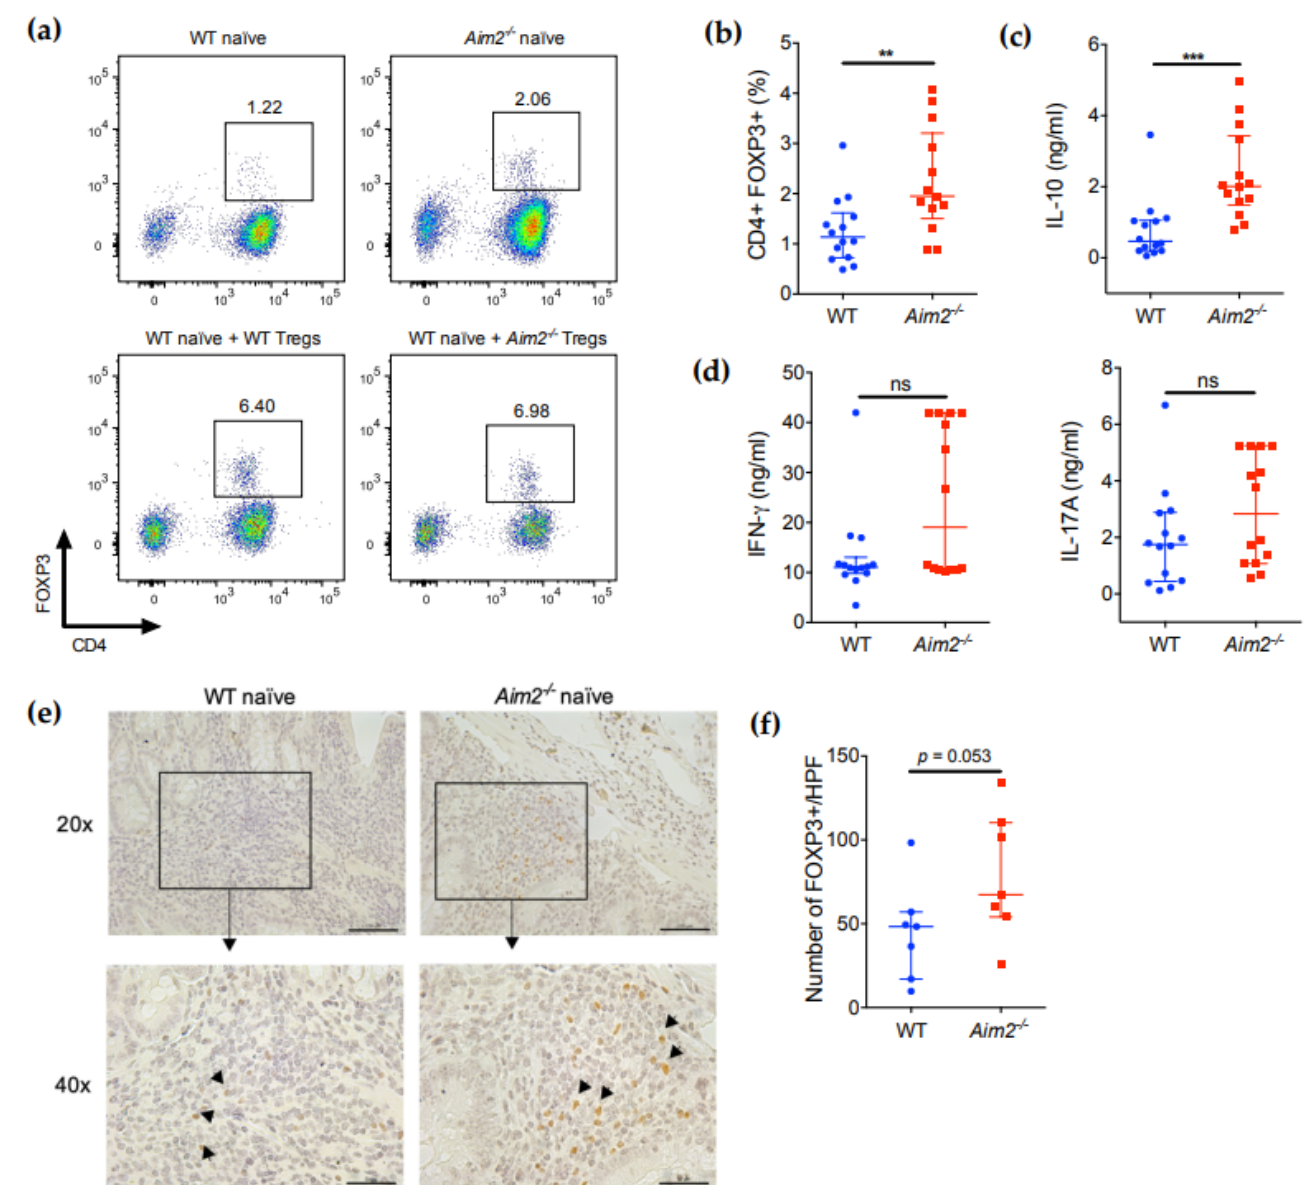
Figure 5. Aim2 − / − naïve T cells show increased differentiation into FOXP3 + cells in vivo. ( a ) Flow cytometry analysis of FOXP3 expression in splenic CD4 + cells isolated from Rag1 − / − mice 15 weeks after transfer of naïve T cells (CD4 + CD45RB high CD25 − ) from WT ( n = 14) or Aim2 − / − ( n = 14) mice, or co-transferred with WT naïve T cells plus CD4 + CD45RB low CD25 + regulatory T (Treg) cells from either WT ( n = 8) or Aim2 − / − ( n = 10) mice. Images are representative of two independent experiments. ( b ) Quantitative analysis of the percentages of FOXP3 + cells in the spleens of Rag1 − / − mice after transfer of naïve T cells from WT or Aim2 − / − mice. ( c , d ) Cytokine levels in culture supernatants of CD4 + T cells isolated from the spleens of Rag1 − / − mice after transfer of WT or Aim2 − / − naïve T cells as described in ( a ). Cells were stimulated with anti-CD3/CD28 antibodies for 24 h. ( e ) Immunohistochemistry analysis of FOXP3 + cells in colonic tissue of Rag1 − / − mice receiving either WT or Aim2 − / − naïve T cells as described in ( a ). Scale bars represent 100 µ m (top photographs, original magnification × 20) or 50 µ m (bottom photographs, original magnification × 40). Data shown are representative of one experiment with 7 mice per group. ( f ) Quantitative analysis of the immunohistochemistry analysis described in ( e ). Note: ** p < 0.01, *** p < 0.001, ns = not significant. Data were analyzed using a Mann-Whitney U test and displayed as median ± interquartile range ( b – d , f